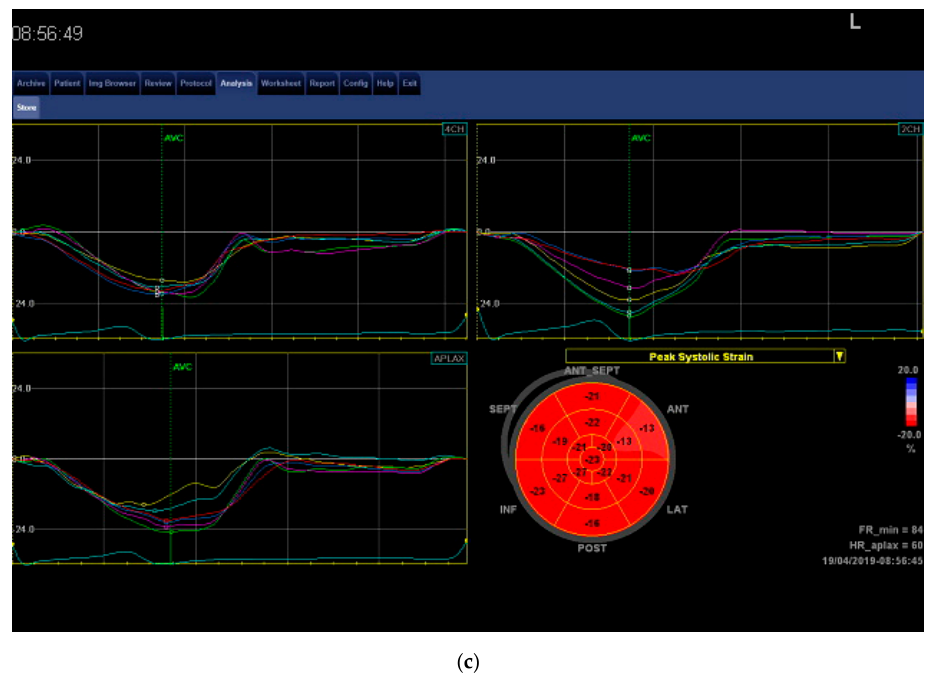
Figure 1. Images of speckle tracking echocardiography. ( a ) Basal rotation of left ventricle (BR)—short parasternal axis at the mitral valve / base level is shown. ( b ) Basal circumferential strain of left ventricle (BCS)—short parasternal axis at the mitral valve / base level is shown. ( c ) Global longitudinal strain of left ventricle (GLS): (C1) longitudinal strain in 4Ch; (C2) longitudinal strain in 2Ch view; (C3) longitudinal strain in left parasternal long axis view (LAX) view; and (C4) bull’s eye mapping analysis.